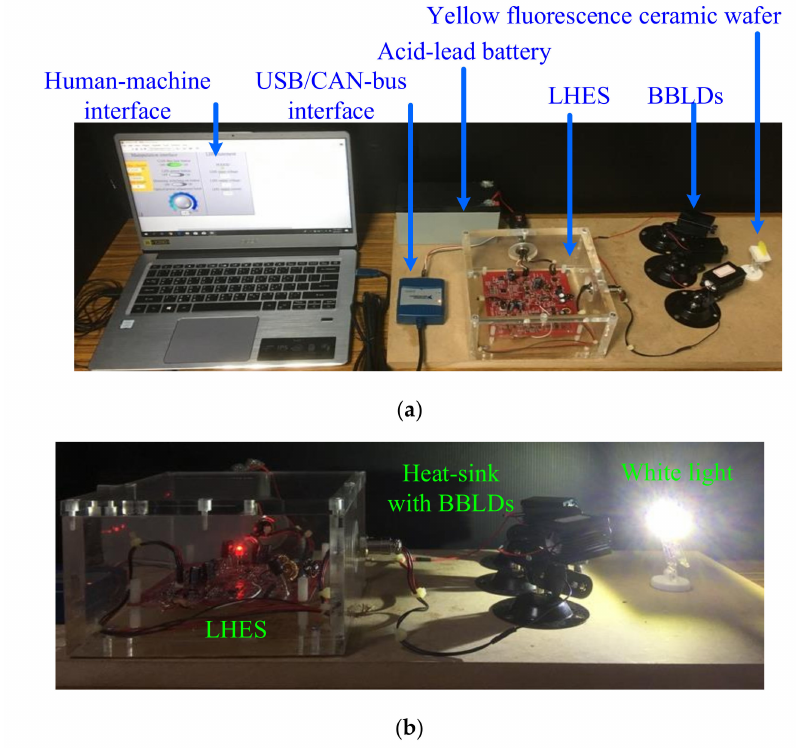
Figure 25. The developed LHES. ( a ) LHES prototype. ( b ) Blue laser beams transformed into white